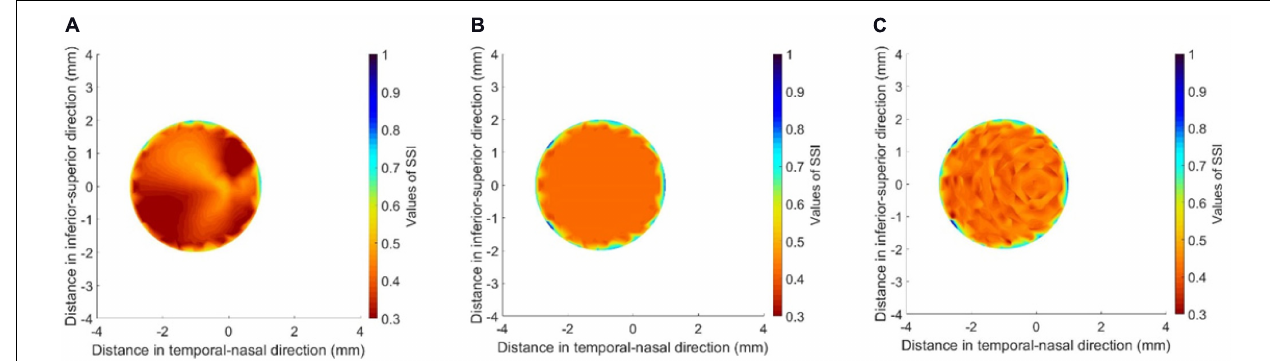
FIGURE 7 | SSI maps for the cone areas in the three models depicted in Figure 6 including (A) a model with the same fibril arrangement as in healthy tissue but with 60% fibril reduction in the cone, (B) a model with uniform and isotropic fibril distribution in the cone, and (C) a model in which the variation of fibril density from point to point within the cone, as well as the anisotropy at each point, was made